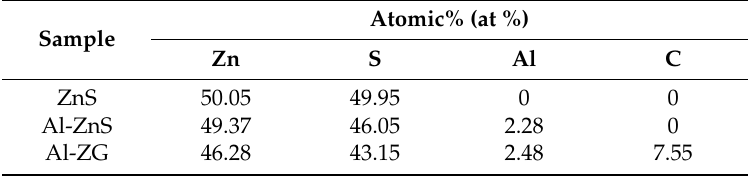
Table 1. Atomic% of elements from the XPS data for the pure ZnS, Al-ZnS and Al-ZG.